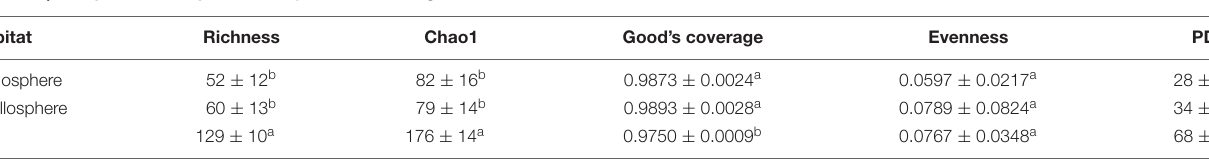
FIGURE 1 | Fungal class distribution among habitats. Any classes accounting for less than 1% abundance are classified as “Others.” TABLE 1 | Comparison of alpha diversity indexes among habitats.